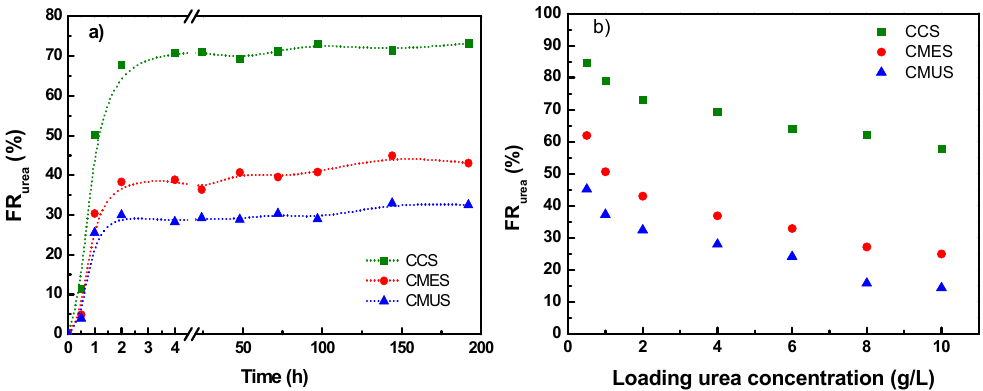
Figure 8. ( a ) Kinetics of urea release, and ( b ) urea release at different loading concentrations on grafted starches.